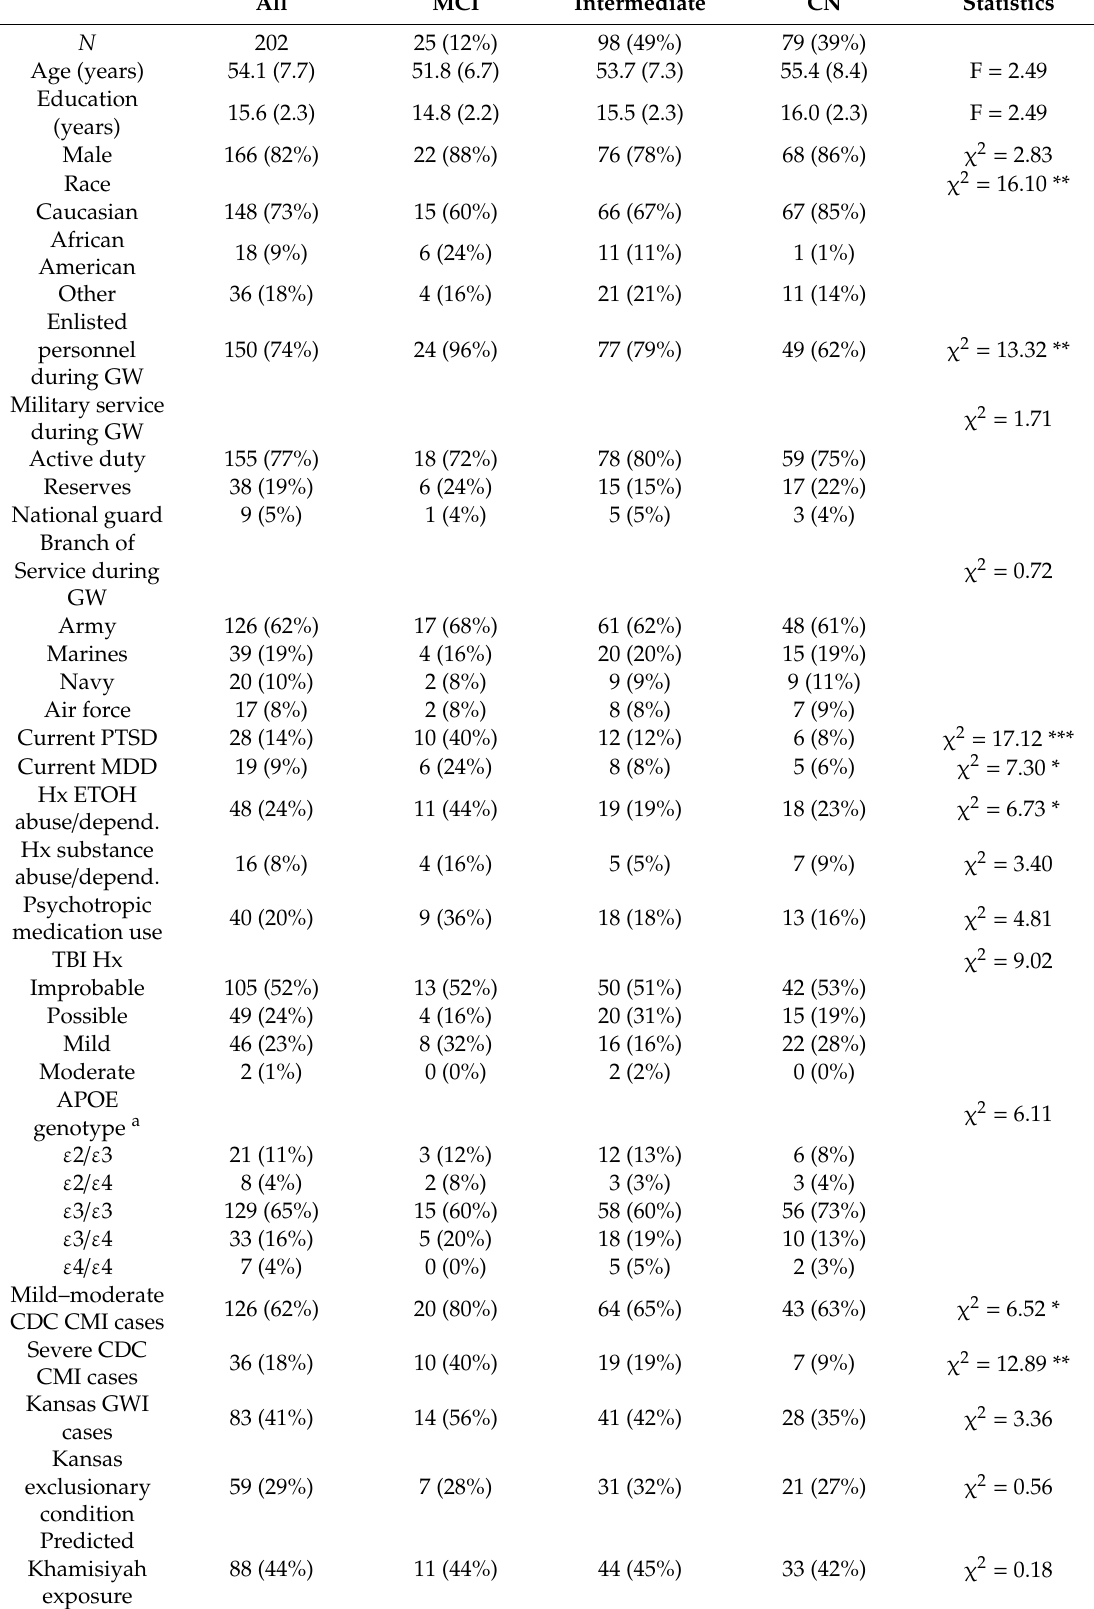
Table 3. Demographic and clinical characteristics in the entire study sample and by cognitive